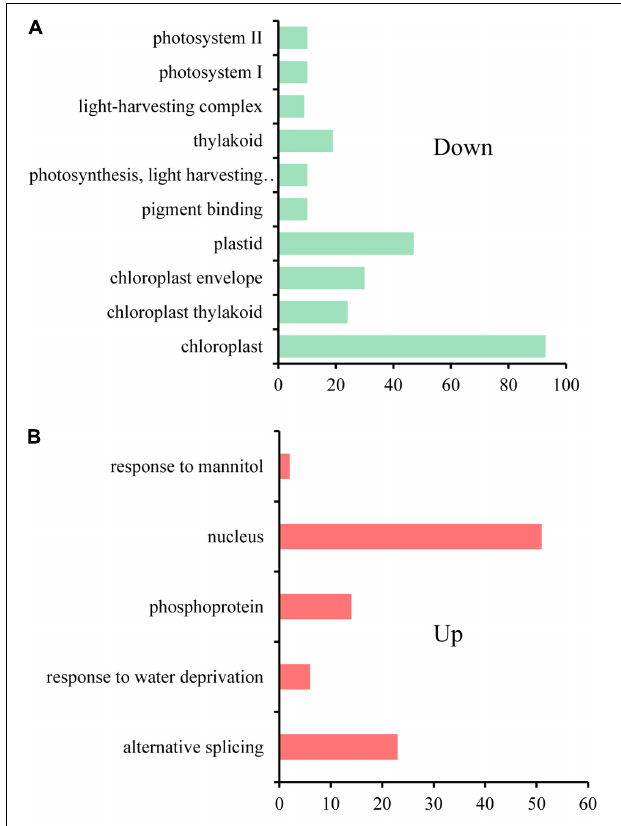
FIGURE 4 | The gene ontology analysis for common trans -effected DEGs in the comparisons of RBR vs. C1 and RBR vs. Cs1. (A) The gene annotation terms for down regulated genes. (B) The gene annotation terms for up regulated